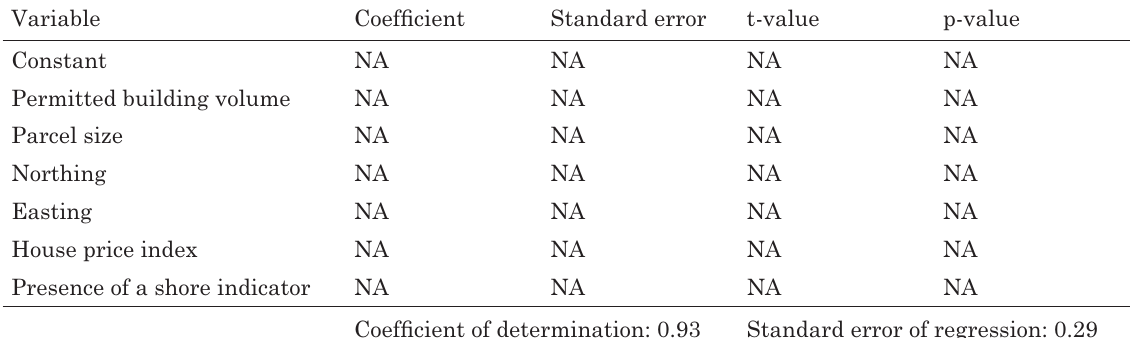
Table 5. Fit of the local regression